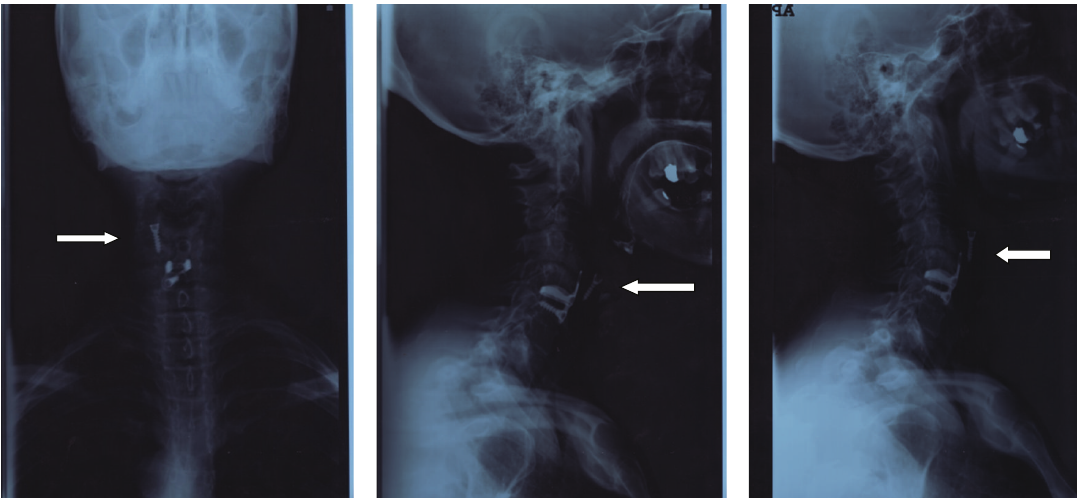
Figure 2: X-ray with contrast medium: the arrow clearly indicates the migration of the screw from the prosthesis in posteroanterior, right lateral, and left lateral projections.